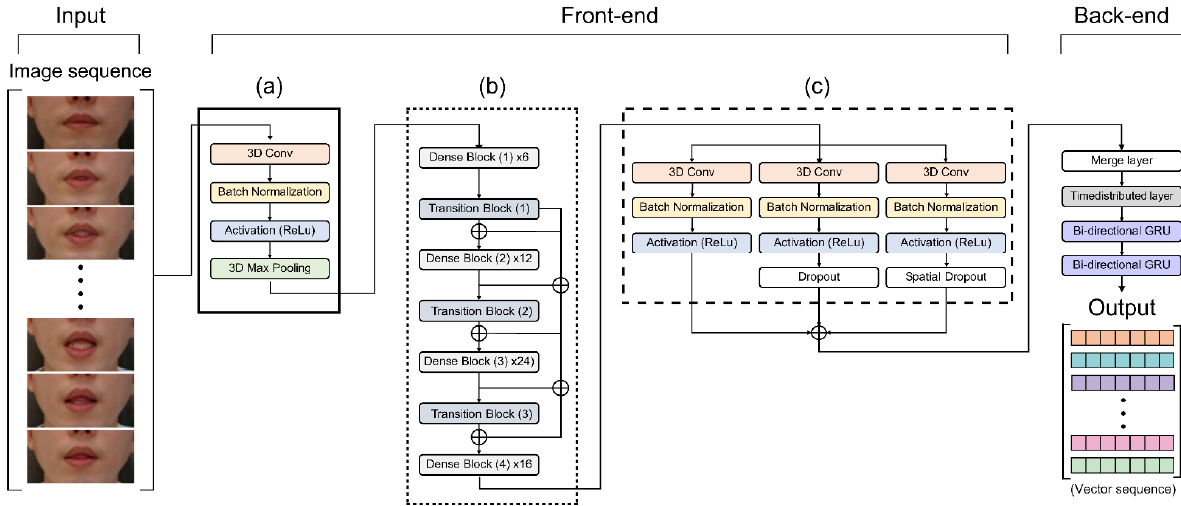
Figure 3. Proposed VSR system architecture. ( a ) 3D CNN; ( b ) 3D dense connection CNN; ( c ) multi-layer 3D CNN.